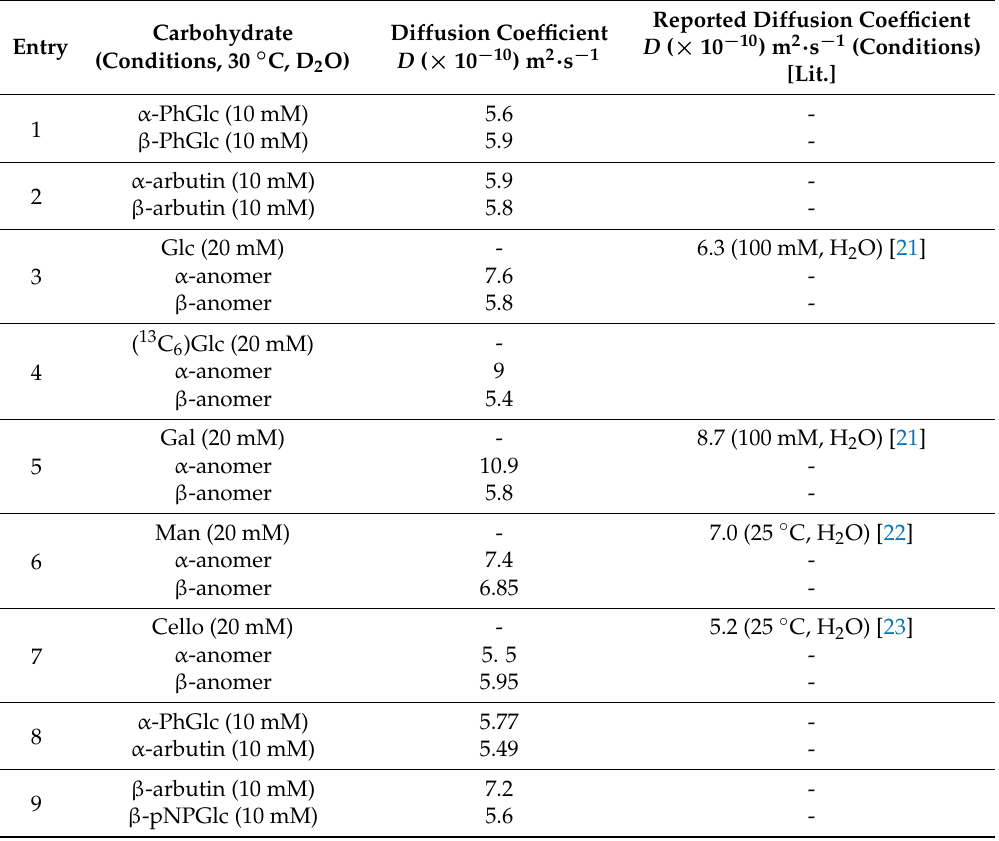
Table 1. Diffusion coefficients of carbohydrate anomers measured in this study and their reported